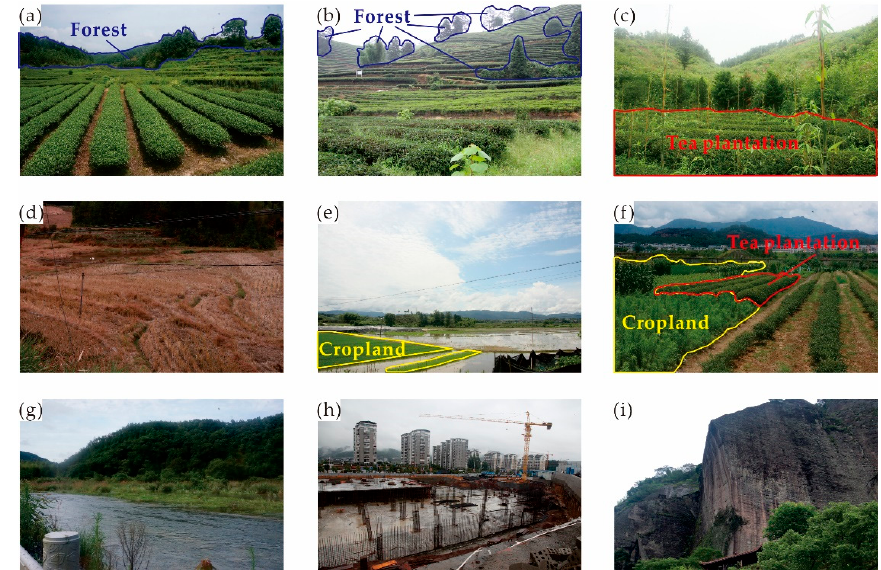
Figure 2. Results of field surveys in the study area: ( a ) tea plantation in the flat area, ( b ) tea plantation on hillside, ( c ) tea plantation and forest, ( d ) cropland in winter, ( e ) cropland in summer, ( f ) mixed planting of tea and crops, ( g ) waterbody, ( h ) built-up area, and ( i ) rock.